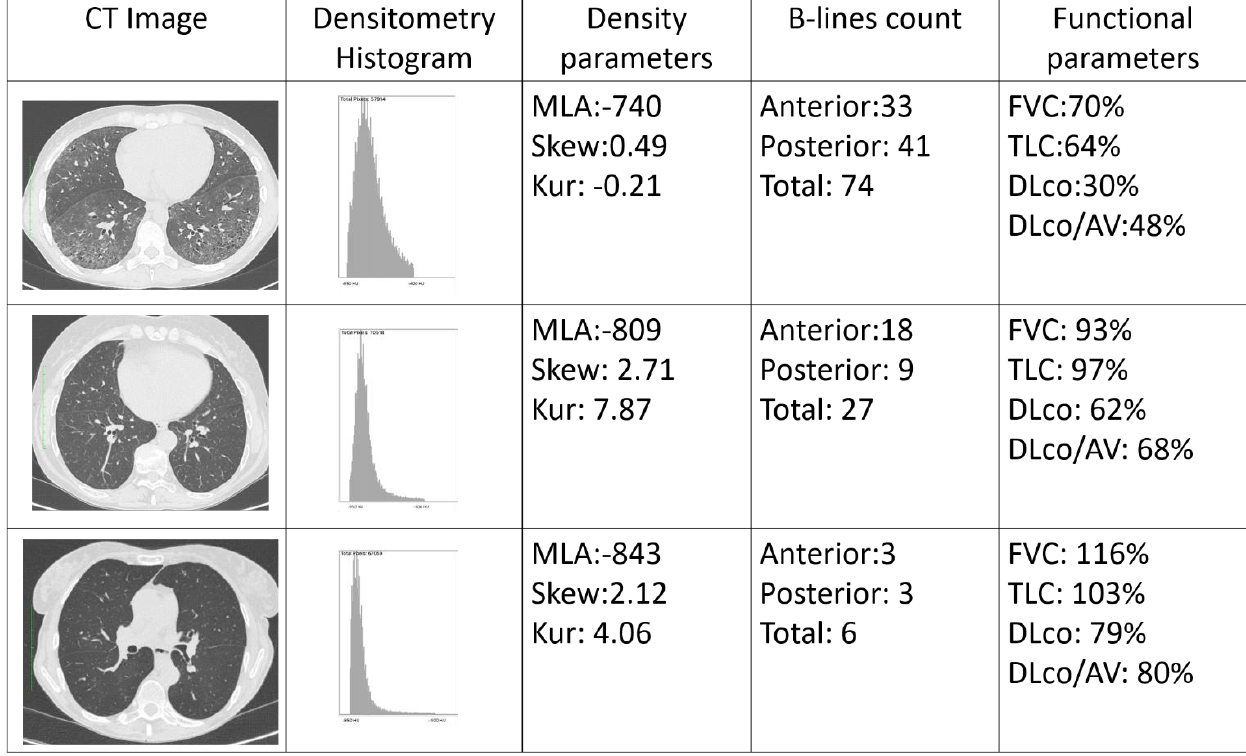
Figure 4. Example of systemic sclerosis patients with extensive ( first-line ), limited ( second-line ) and absent ( third-line ) interstitial lung disease. CT = computed tomography; DLco = diffusion lung capacity of carbon monoxide; DLco/VA = diffusion lung capacity of carbon monoxide corrected for alveolar volume; FVC = forced vital capacity; KUR = kurtosis; MLA = mean lung attenuation, measured in Hounsfield unit; SKEW = skewness; TLC = total lung capacity.